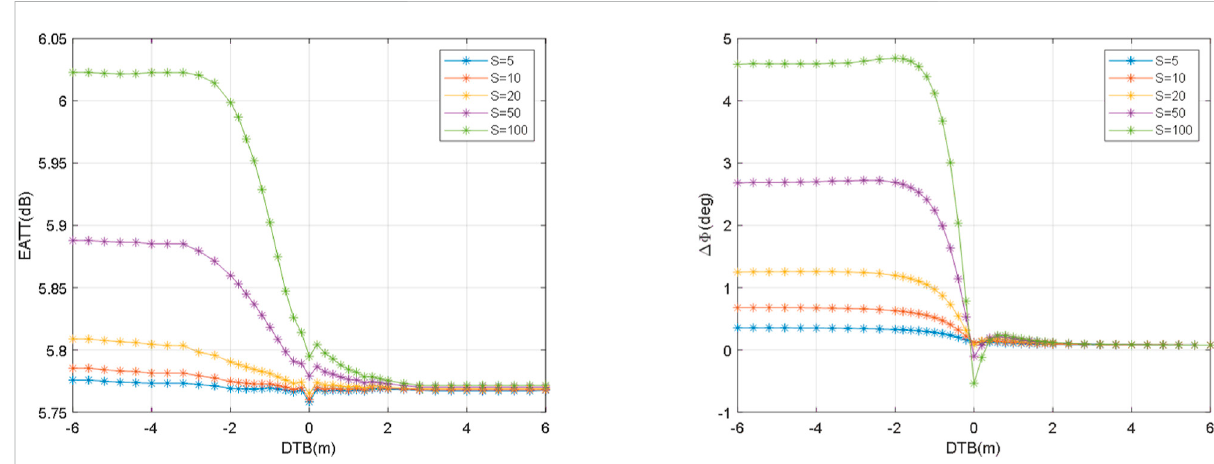
FIGURE 4 Response of the axial receiver in different contrast ratio stratum models.